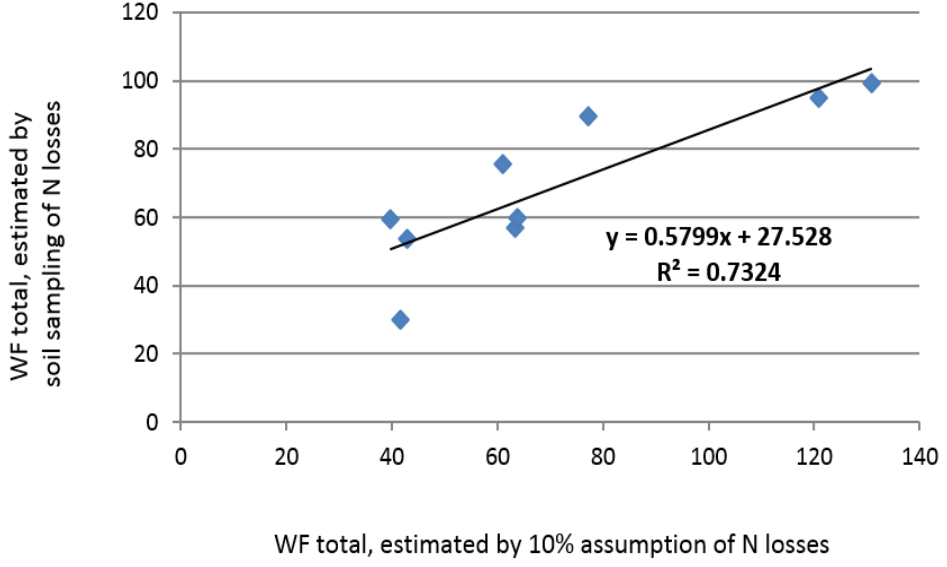
Figure 4. Correlation of total WF values estimated by the two approaches. Figure 5. Correlation of total WF values estimated by the two